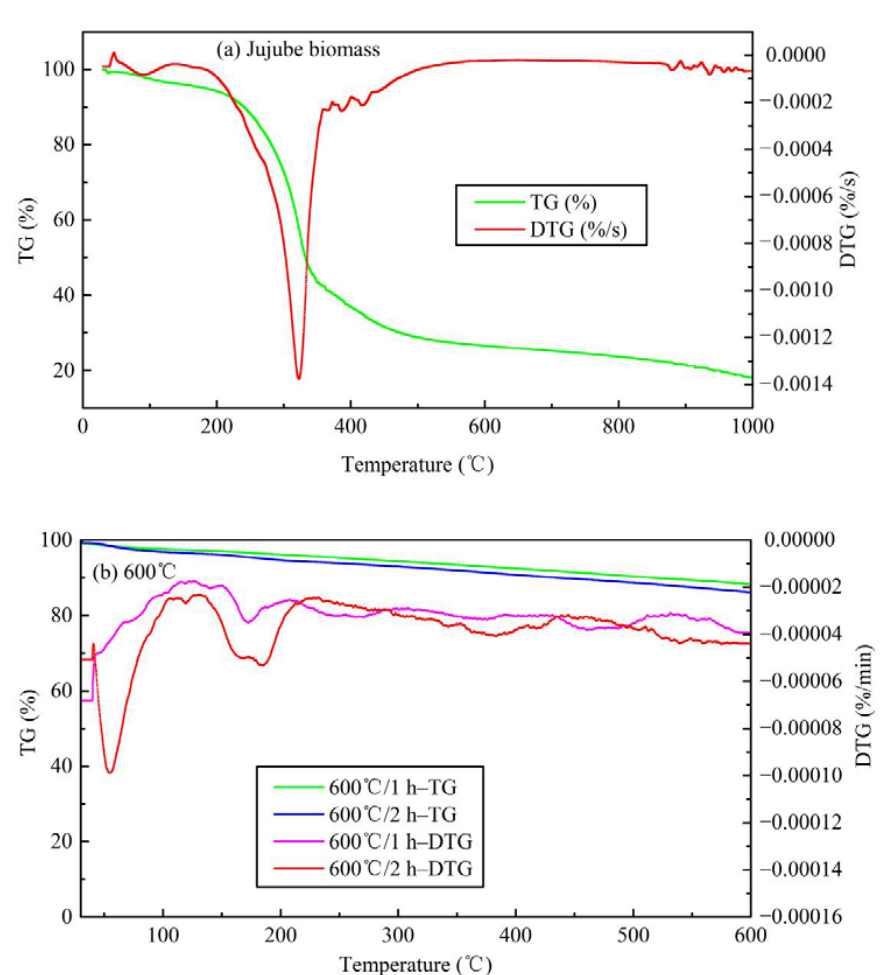
Figure 6. Thermogravimetric analysis of TG and DTG curves for jujube biomass and JB. ( a ) for jujube biomass; ( b ) for 600 °C.